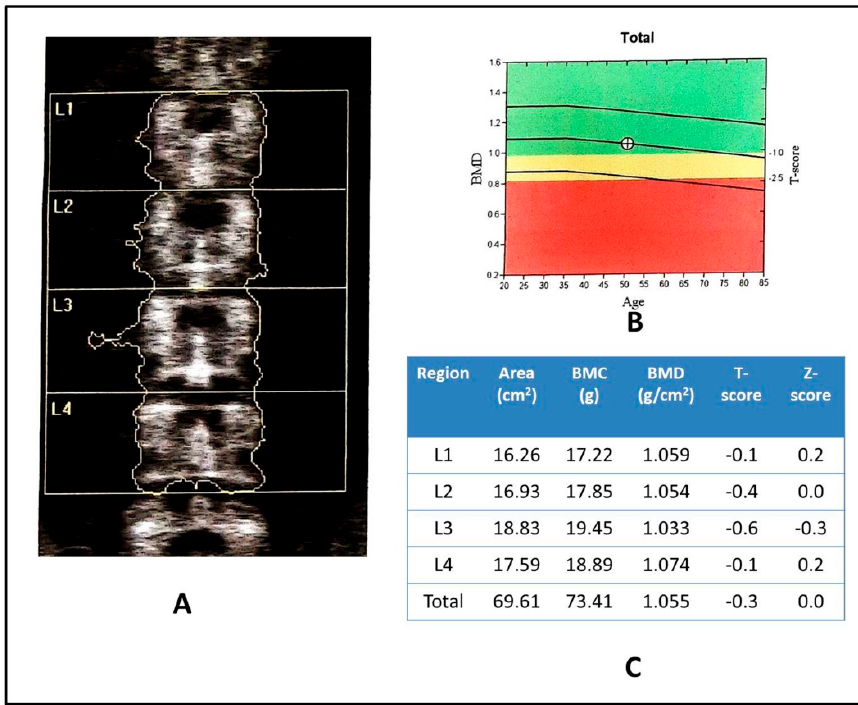
Figure 2. T scores obtained from dual X-ray absorptiometry (DXA) results. ( A ): Anatomical site L1, L2, L3 and L4, image characteristics k = 1.124, d0 = 40.3, 116 × 152. ( B ): T-score vs. White Male. Source BMDCS/Hologic White Male.Z-score vs. Source BMDCS/Hologic White Male. ( C ): Total jawbone mineral density (BMD) coefficient of variation (CV) 1.0%, autocorrelation function (ACF) = 1.039, bias correction factor (BCF) = 1.018, Total Hip (TH) = 10.313, Interpretation WHO Classification: Normal,